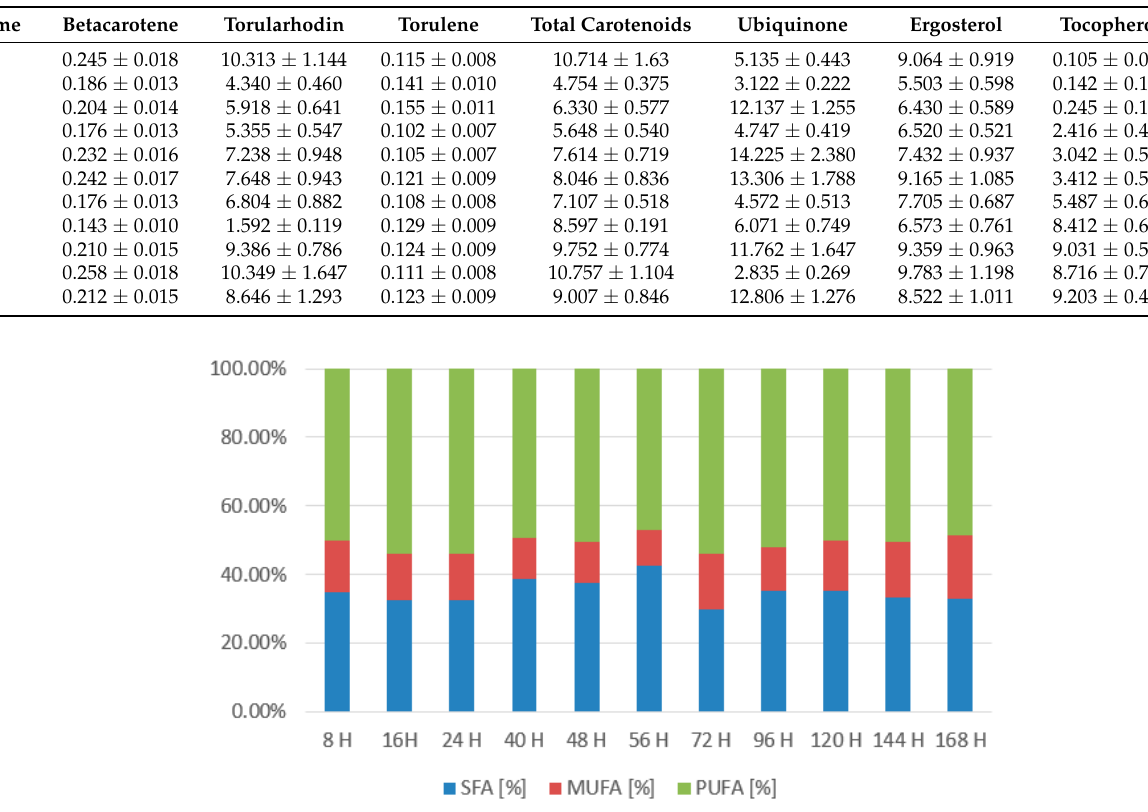
Figure 10. Biomass, lipid, and β -glucan production of Rhodotorula kratochvilovae in a bioreactor cultivation on coffee oil and glycerol with lipase induction. Table 7. HPLC analysis of bioreactor cultivation of Rhodotorula kratochvilovae cultivated on coffee oil and glycerol with lipase induction. Productions are listed in mg/g of cell dry weight.